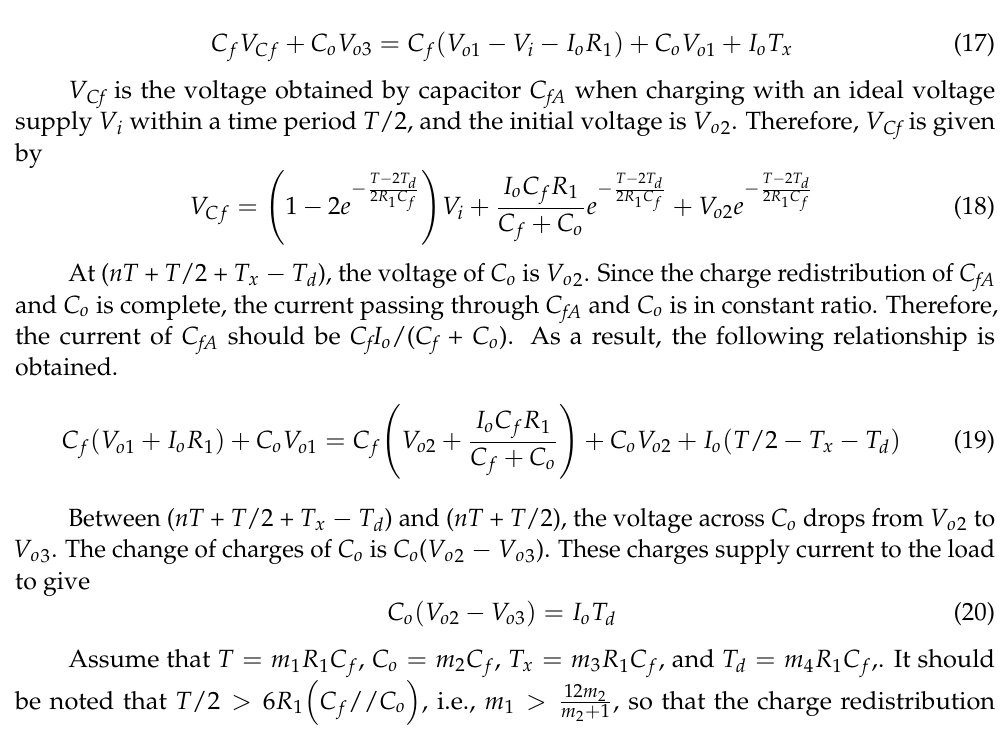
Figure 8. Switching of 2-stage cross-coupled voltage doubler ( a ) Φ 1 = 1; Φ 2 = 0 ( b ) Φ 1 = 0; Φ 2 = 1 ( c ) Φ 1 = 0; Φ 2 = 0 (i.e.,